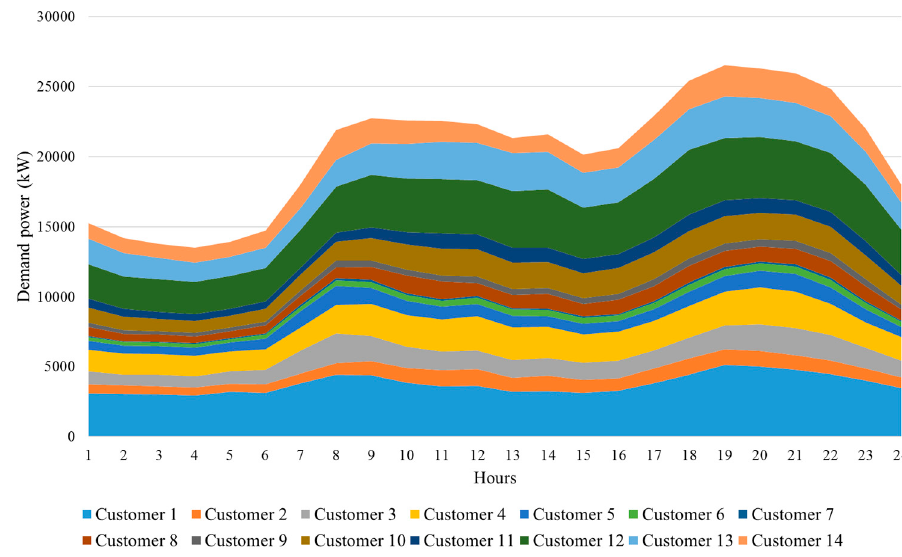
Figure 7. Forecasted demand of customer groups.